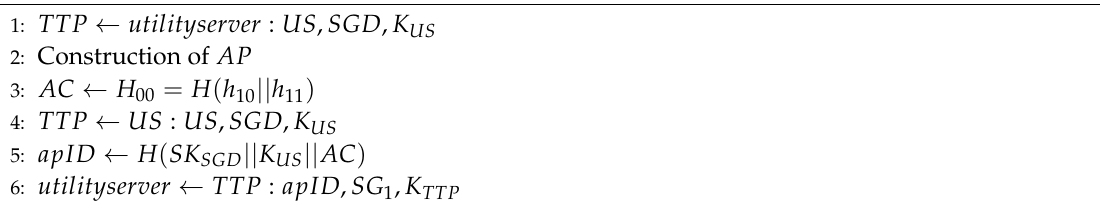
Algorithm 1 Generation and issuance of access policy, apID and authentication code by the KMS to the utility